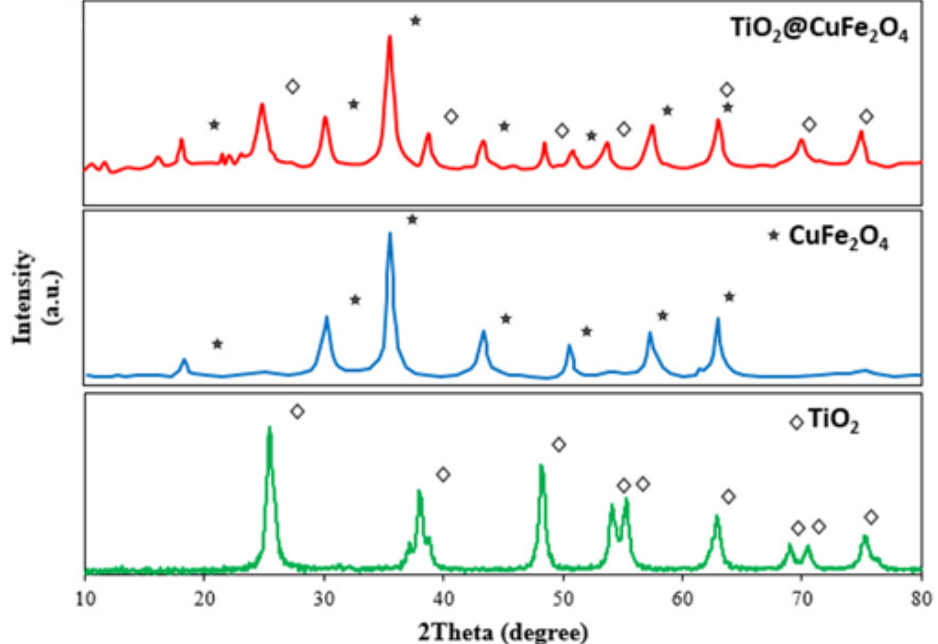
Figure 10. XRD patterns of neat TiO 2 , neat CuFe 2 O 4, and nanocomposite TiO 2 /CuFe 2 O 4 [109]. Republished with permission from Elsevier.